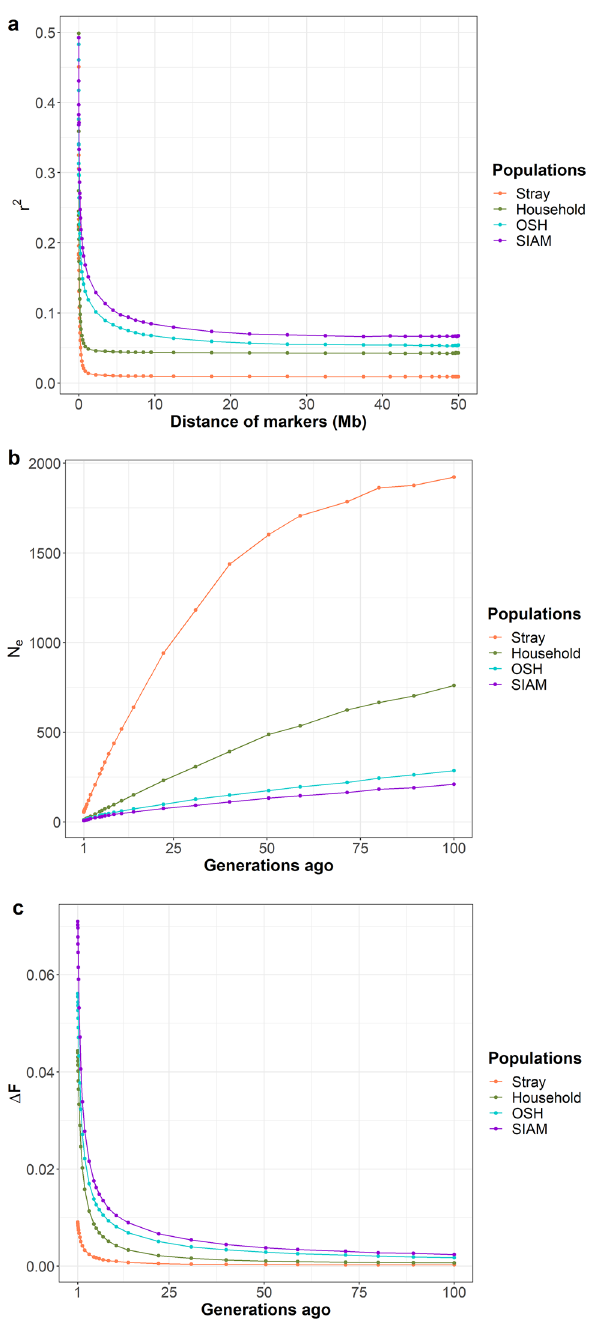
Figure 4. Analysis of linkage disequilibrium among SNP loci. ( a ) Decay of linkage disequilibrium (r 2 ) between SNP pairs bridging an increasing distance in stray, household, OSH and SIAM, respectively. ( b ) Effective population size (Ne) of each population over the last 100 generations. The ancestral Ne was estimated from the mean r 2 for the 18 cat autosomes. ( c ) Increase in inbreeding (ΔF) in each population in the last 100